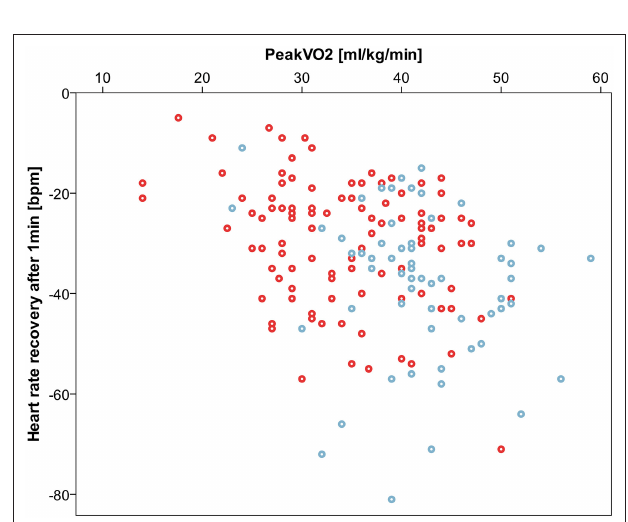
FIGURE 3 | Frequency of chronotropic incompetence normalized to healthy controls (threshold defined as chronotropic index < 0.69 corresponding to the 2.5th percentile of chronotropic index in controls) marked red.